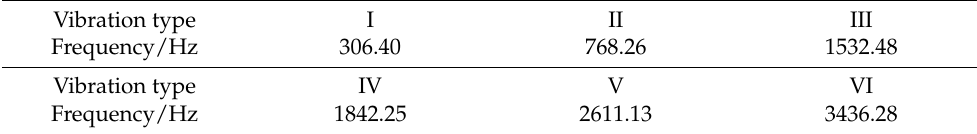
Figure 10. Circuit board locking device optimization. Table 5. The first six frequencies of the CPU board.